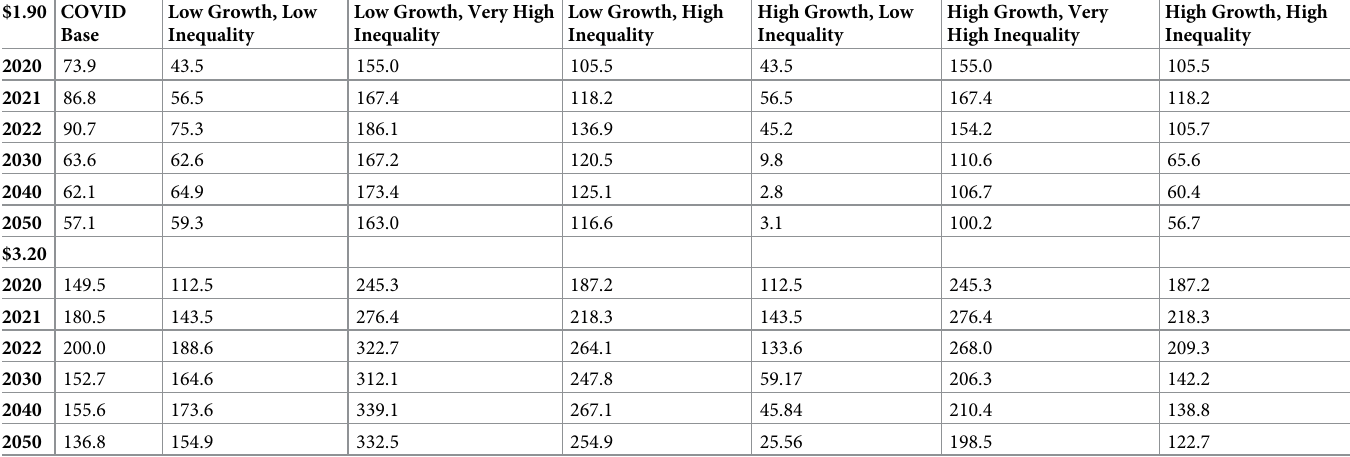
Table 3. Increase in global population living on less than $1.90 per day and $3.20 per day by scenario and time relative to the No COVID Base scenario, millions of people. $1.90 COVID